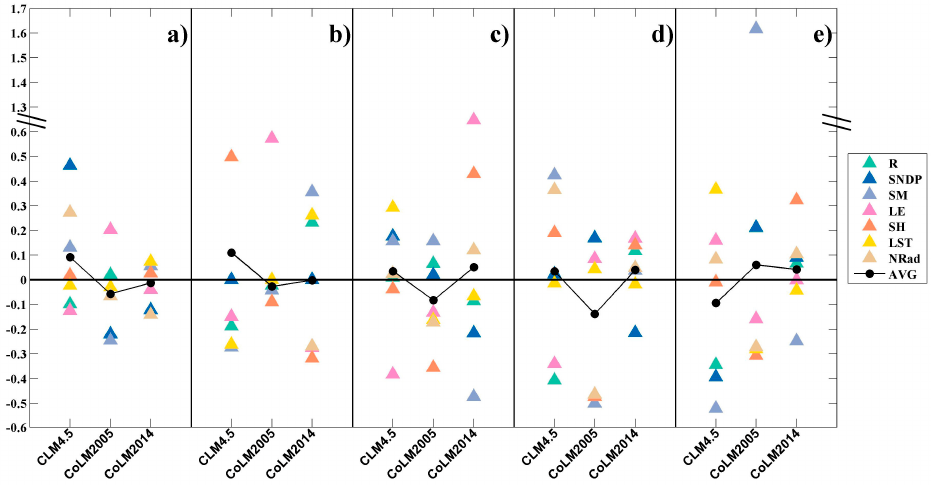
Figure 21. Relative errors for ( a ) annual mean global mean fields and regional seasonal cycles in the ( b ) Amazon; ( c ) Tibetan Plateau; ( d ) Siberia; and ( e ) Central US focus domains. Black solid circles show total MCPI in each region. Colored triangles show relative errors for each of the variables that contribute to the total MCPI. Negative values indicate better than average agreement with the corresponding validation standard.